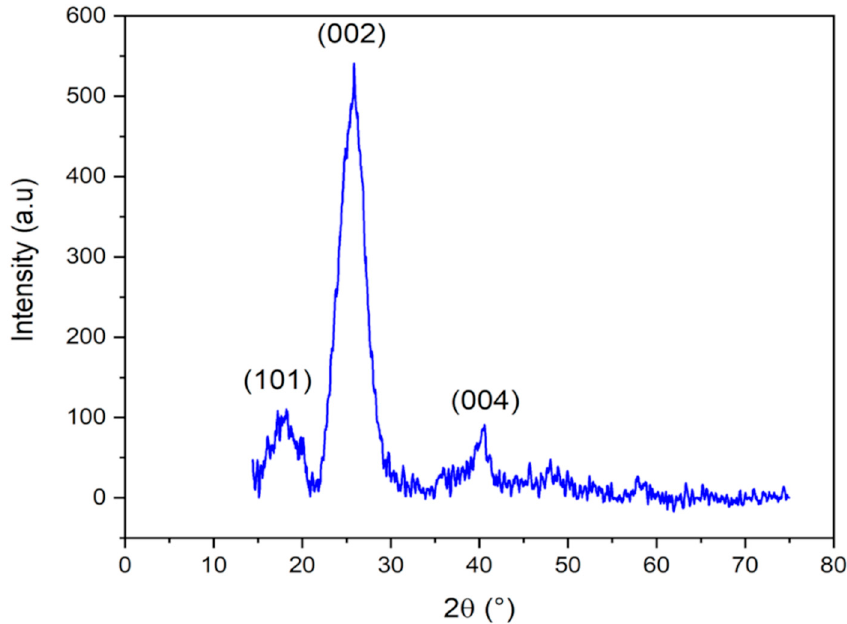
Figure 5. TVF XRD